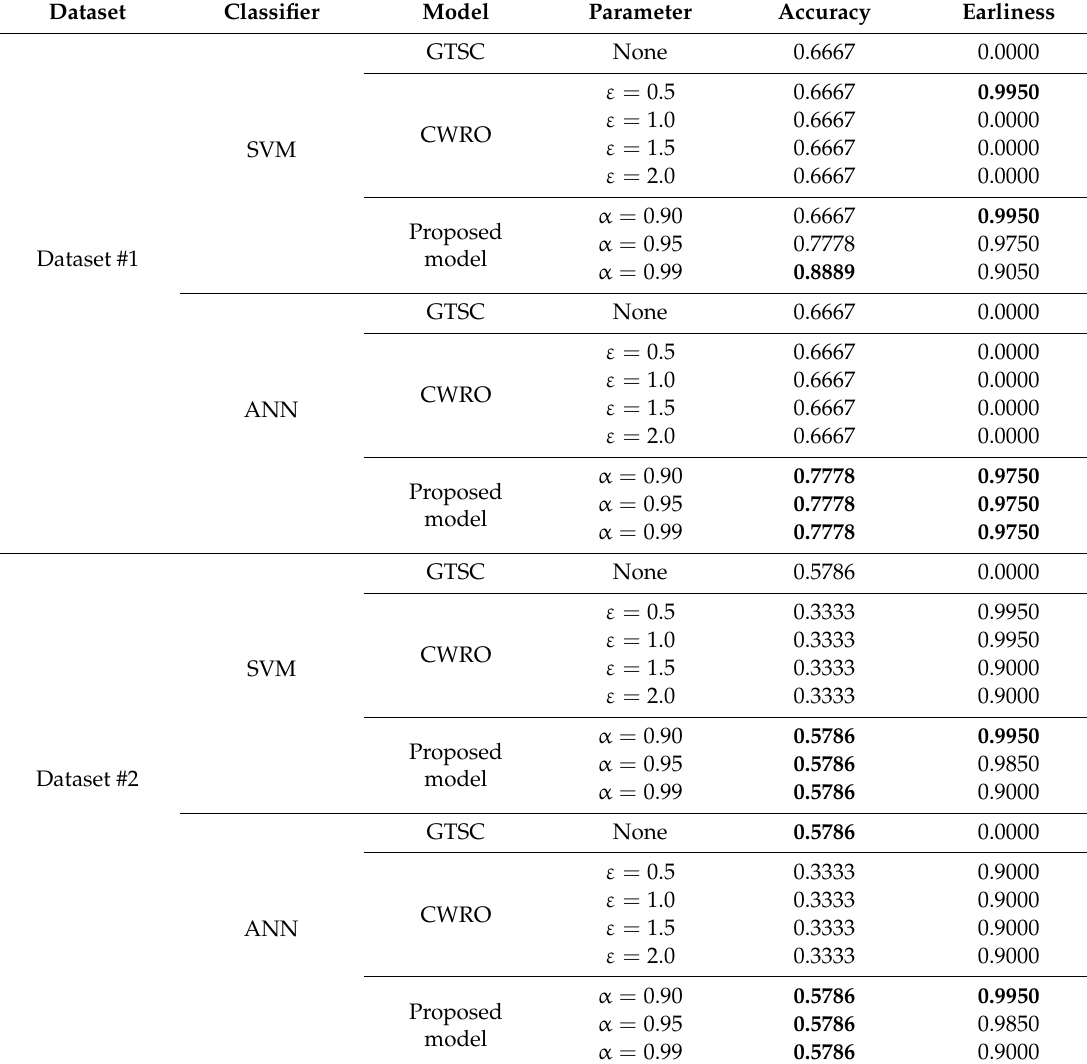
Table 3. Performance analysis